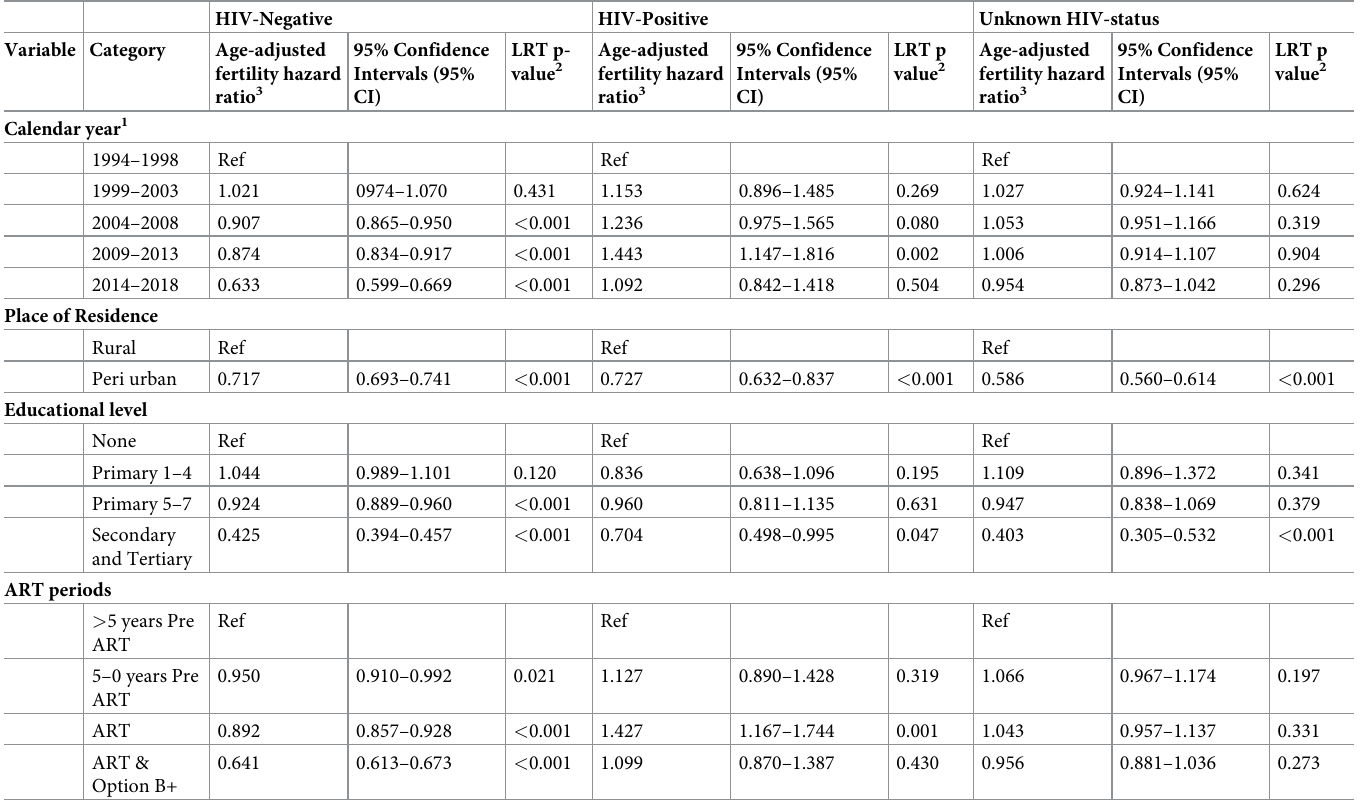
Table 2. Factors associated with fertility changes among women aged 15–49 between January 1994to December 2018 by HIV